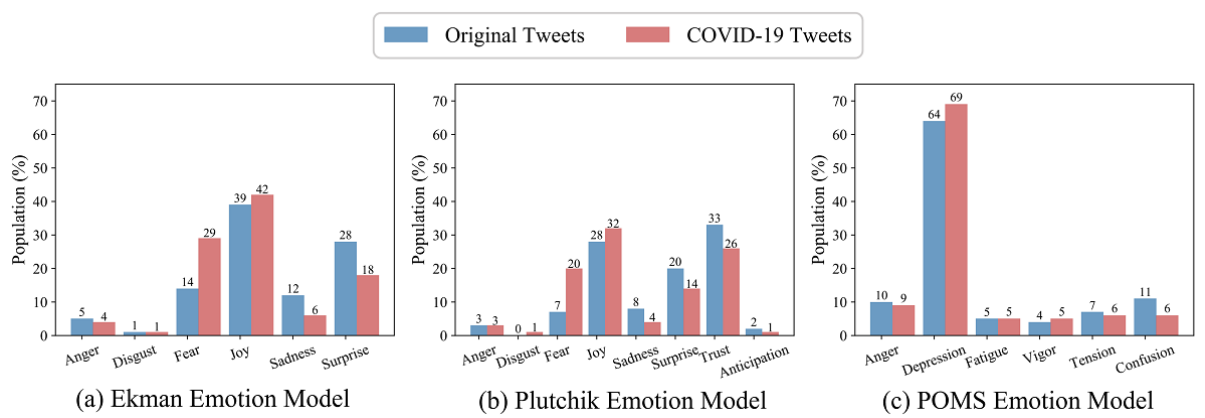
Figure 8. The population distributions of the three emotion models. POMS: Profile of Mood